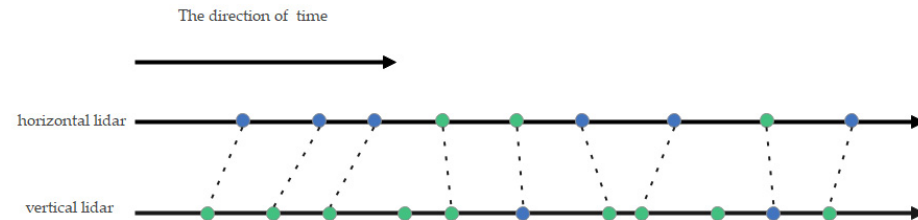
Figure 5. Timestamp matching of dual lidar.